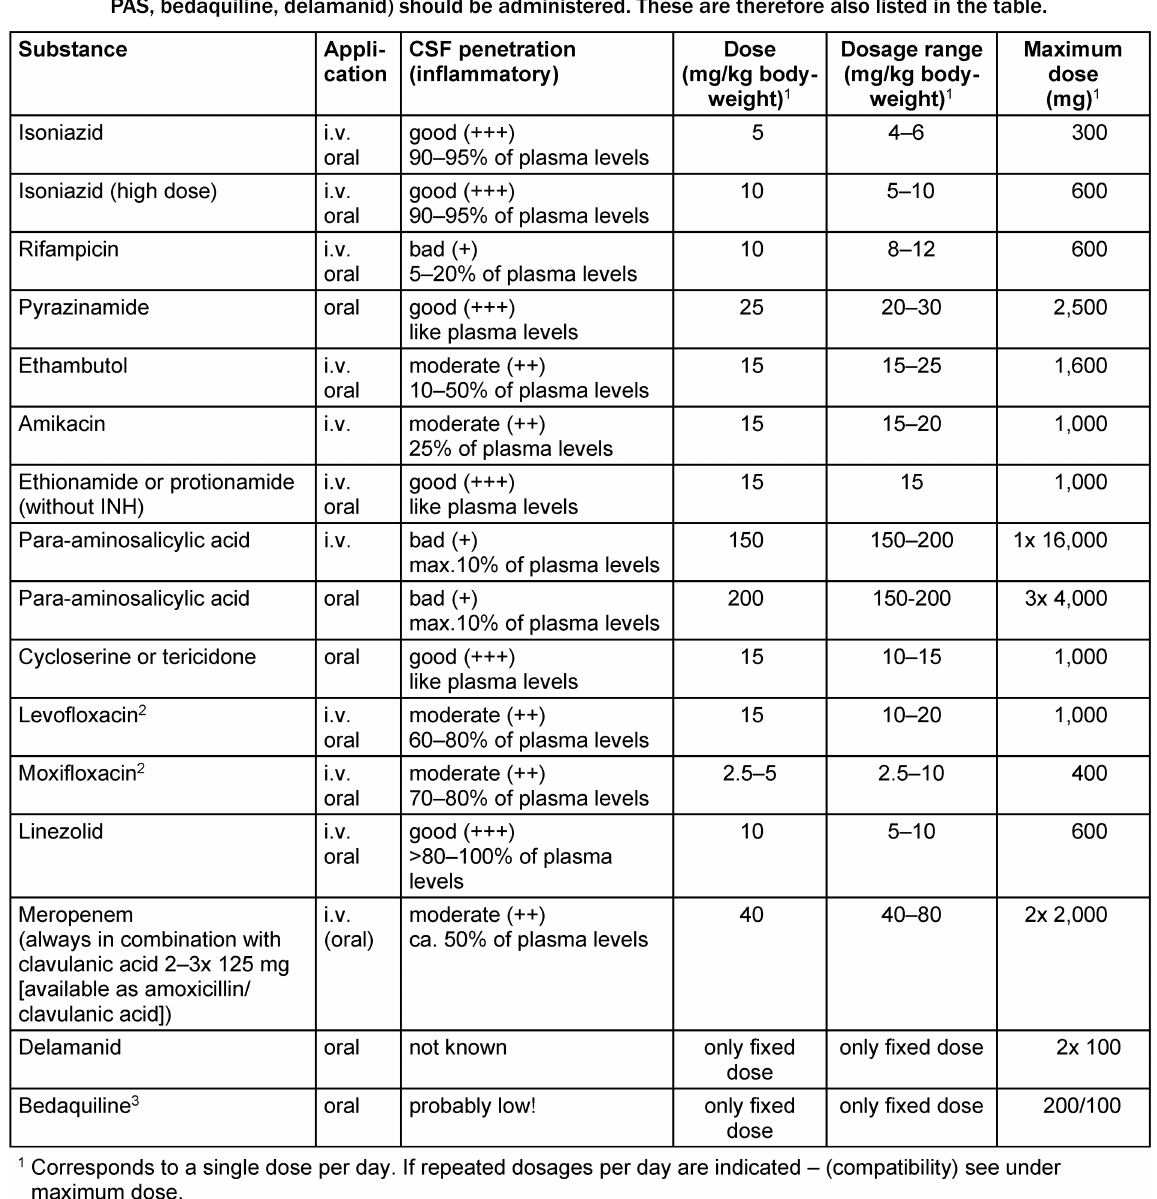
Table 4: Tuberculous meningitis: Dosage recommendations according to national and international guidelines. Due to intolerance or resistance to standard substances of tuberculosis treatment in each case combination treatment with 4 effective tuberculosis drugs should be performed. If necessary, in addition to parenteral administration, only orally available agents (such as